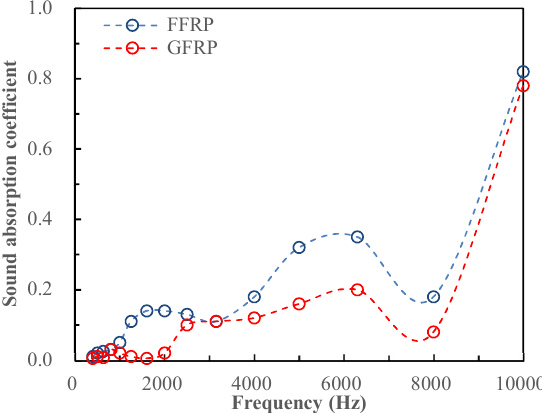
Figure 8. The experimental sound absorption coefficients of FFRC and GFRC with frequency.